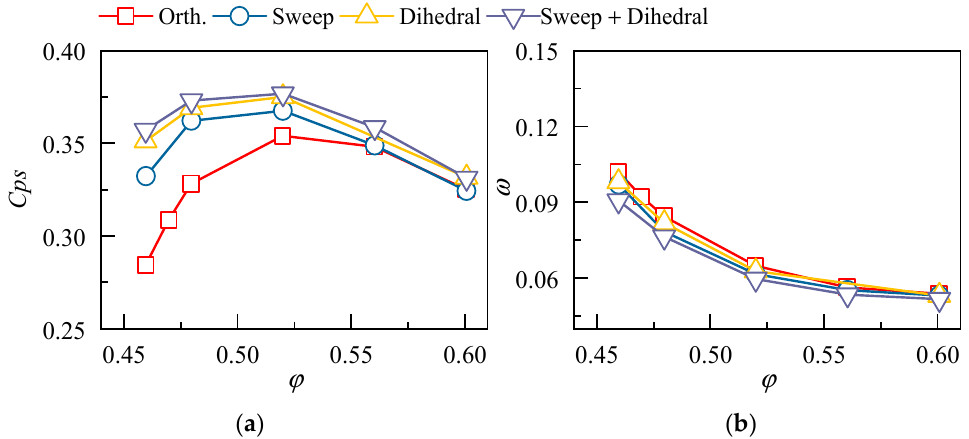
Figure 26. Pressure rise and loss characteristics for the 3D cantilevered stator. ( a ) Pressure rise; ( b ) loss.